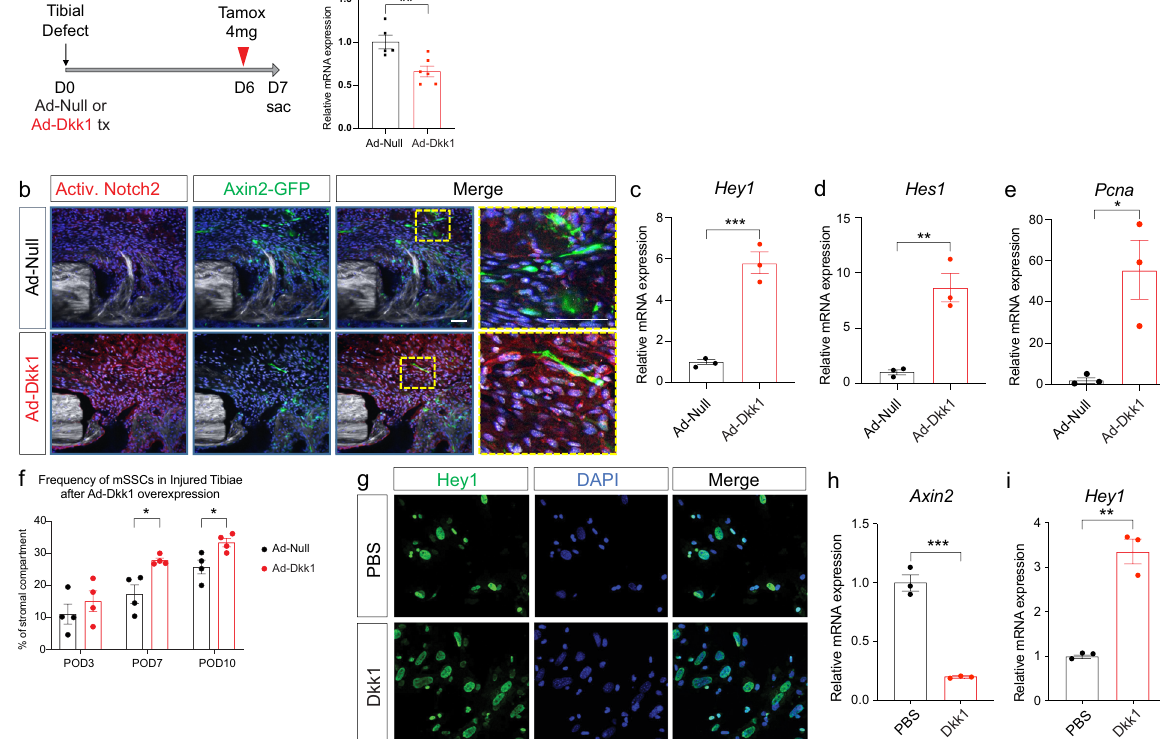
Fig. 3 Wnt inhibition sustains Notch activation and lengthens the proliferative phase. a Ad-Null (control) or Ad-Dkk1 (Wnt antagonist) was administered around tibial defect sites of iAxin2/GFP reporter mice and tamoxifen was injected at POD 6 (24 h before euthanasia) ( n = 5 – 6). Axin2 expression levels were signi fi cantly decreased at day 3 after Ad- Dkk1 administration, con fi rming Wnt inhibition. b Immuno fl uorescence staining against NICD2 (activated Notch2 intracellular domain) reveals near absent Notch activation in the control injury, while the majority of cells in the injury site treated with Ad- Dkk1 showed NICD2 staining. iAxin2/GFP IF con fi rmed successful Wnt inhibition. n = 3. Scale bar = 50 μ m. c , d Notch target gene expression and e proliferative cell nuclear antigen ( Pcna) gene expression from POD7 callus reveal activated Notch signaling in Ad- Dkk1 treated injuries with increased proliferation ( n = 3). f FACS analysis of SSCs in the fracture callus of Ad- Null and Ad- Dkk1 treated animals at POD 3, 7, and 10 ( n = 4) showing increase of SSC number during the proliferative phase after Wnt inhibition. g Primary bone marrow derived stromal cells were treated with PBS (control) or recombinant Dkk1 protein for 48 h in vitro. Hey1 IF shows an increased number of Notch activated cells after Dkk1 treatment. Experiments were performed in triplicate and repeated at least twice. h Axin2 expression is decreased after Dkk1 treatment. i Resulting in increased Hey1 gene expression ( n = 3). PBS phosphate buffered saline. * p < 0.05, ** p < 0.01, *** p < 0.001. Data were represented as mean ±